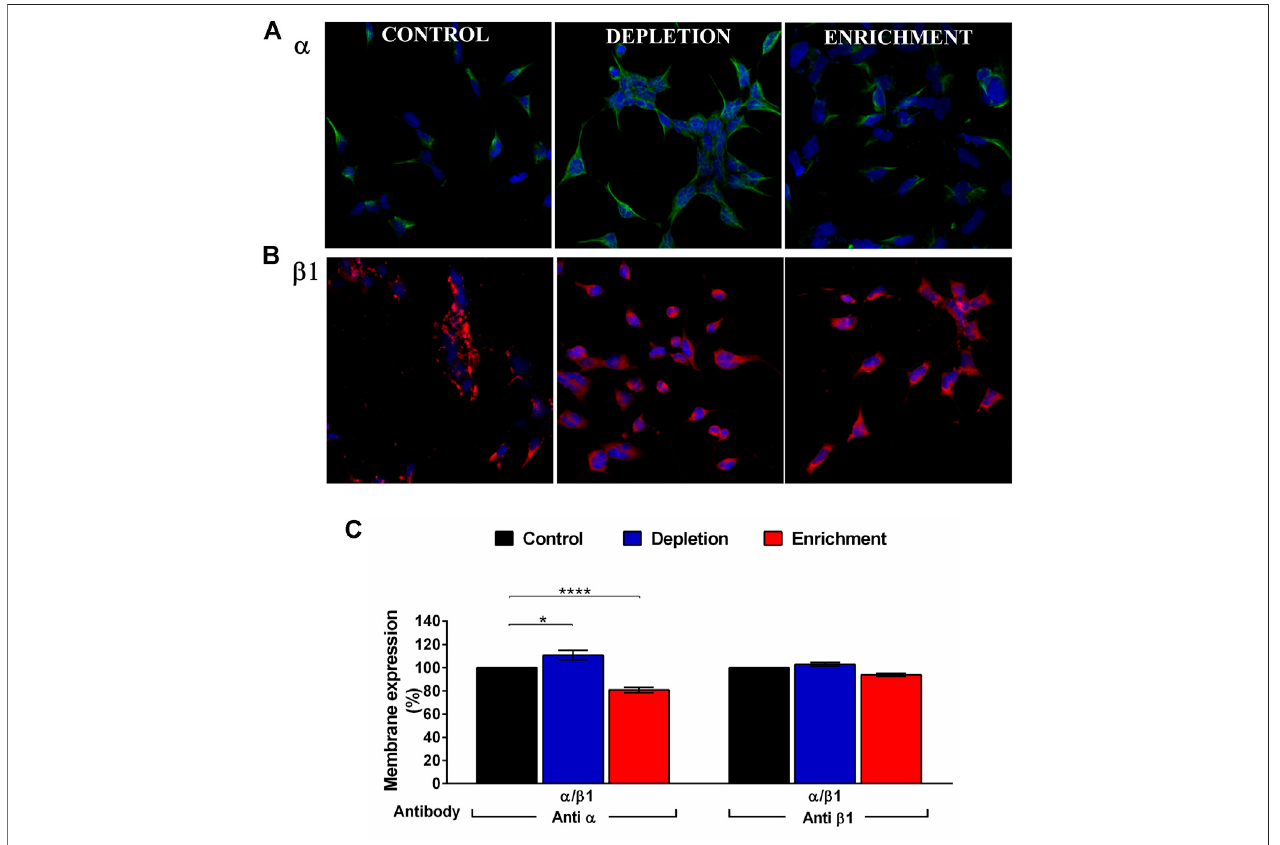
FIGURE 2 | BK channel expression after membrane cholesterol modulation on the HEK 293 transfected cells. (A) Immuno fl uorescence in cells expressing BK α subunit. (B) Immuno fl uorescence on cells expressing β 1 subunit. Green: Anti BK α and Alexa Fluor 488 antibodies. Red: Anti BK β 1 and Alexa Fluor 594. Blue: DAPI nuclear stain. (C) Expression (% of cells) of BK channel subunits in HEK293 cells transfected with α and β 1 subunits using fl ow cytometry. The blue bars represent cholesterol depleted cells; α :110.9% ± 4.1, β 1:102.9% ± 1.7. The red bars are enriched cells. α :80.8% ± 2.3, β 1:93.8% ± 1.4. Black bars represent control cells without treatment. 100%. Error bars: SEM. * p < 0.05, **** p < 0.0001. n (cid:2)